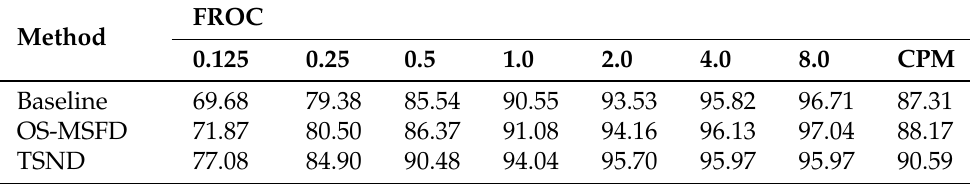
Table 2. Comparison of the FROC metrics with three methods based on the proposed MSFD-Net using the 10-fold cross-validation on the LUNA16 dataset. The sensitivities (%) are shown in the following table, at seven FPs/scan points 0.125, 0.25, 0.5, 1, 2, 4, and 8 on the FROC curve of different methods. Besides, the CPM means the average sensitivity at the seven points described